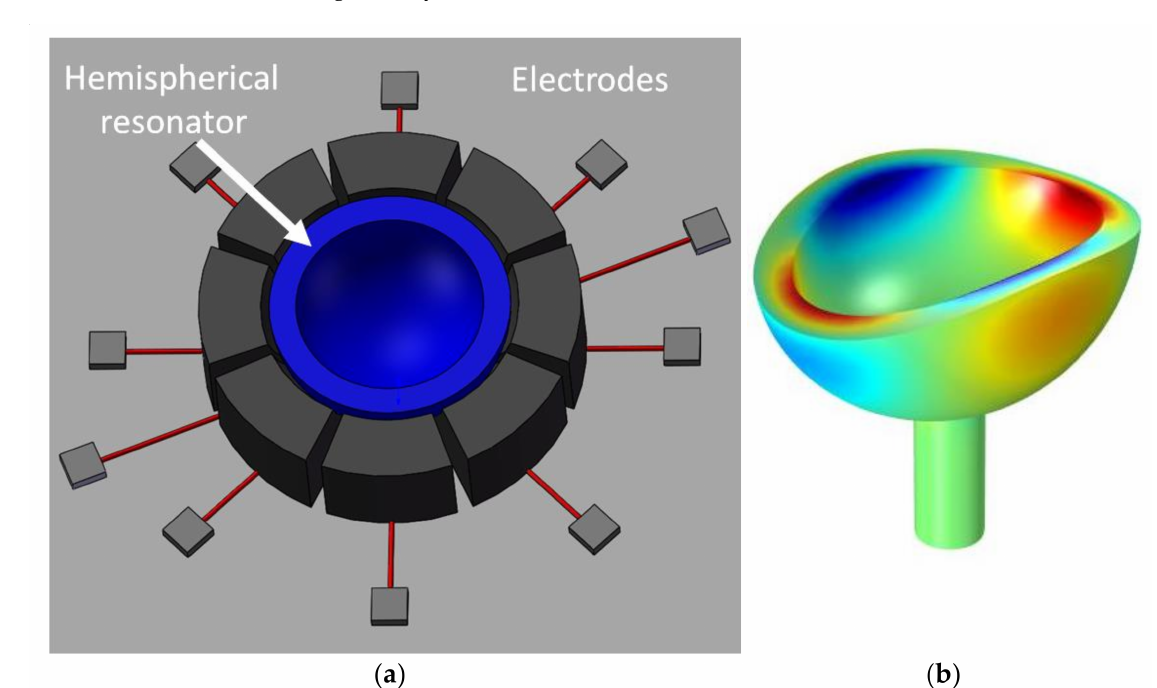
Figure 1. ( a ) Hemispherical shell (Liu et al. [55]), Reproduced with permission from ASME; pub- lished by J. Liu, J. Jaekel, D. Ramdani, N. Khan, D. S.-K. Ting and M. J. Ahamed, “Effect of